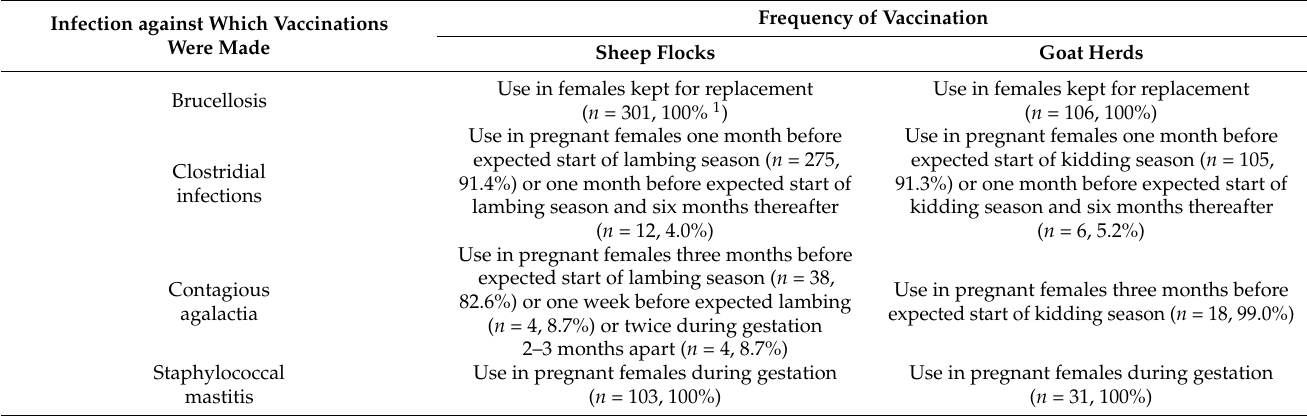
Table 2. Most frequent vaccination programs applied in small ruminant farms in Greece.